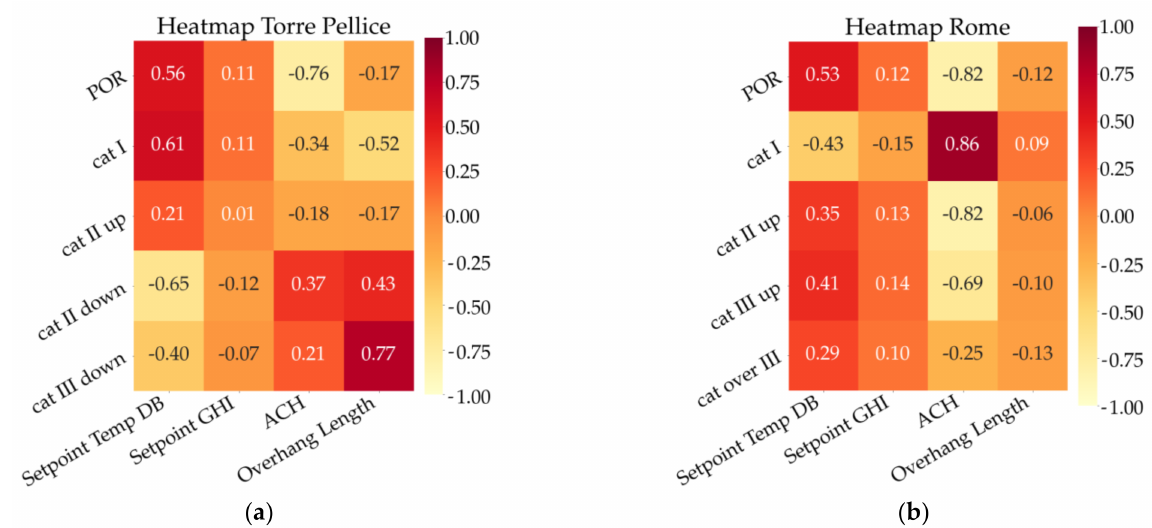
Figure 6. Heatmaps showing correlations of free-running technologies and simulated thermal comfort/discomfort in Torre Pellice ( a ) and Rome ( b ) climates.